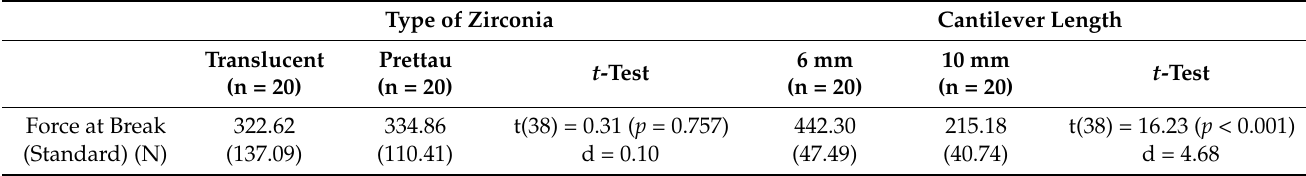
Table 2. Force at break (standard) (N) according to type of zirconia and cantilever length.